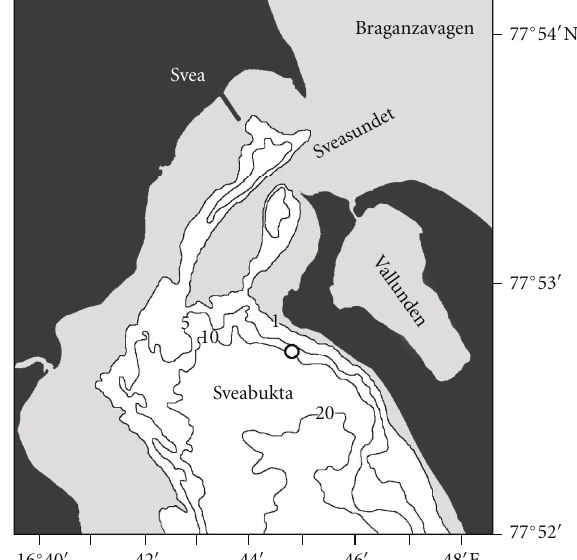
Figure 2: Schematic map of the measurement site. Gray color shows shallow ( < 1m) regions. Black color denotes land. The circle indicates the site of measurements.